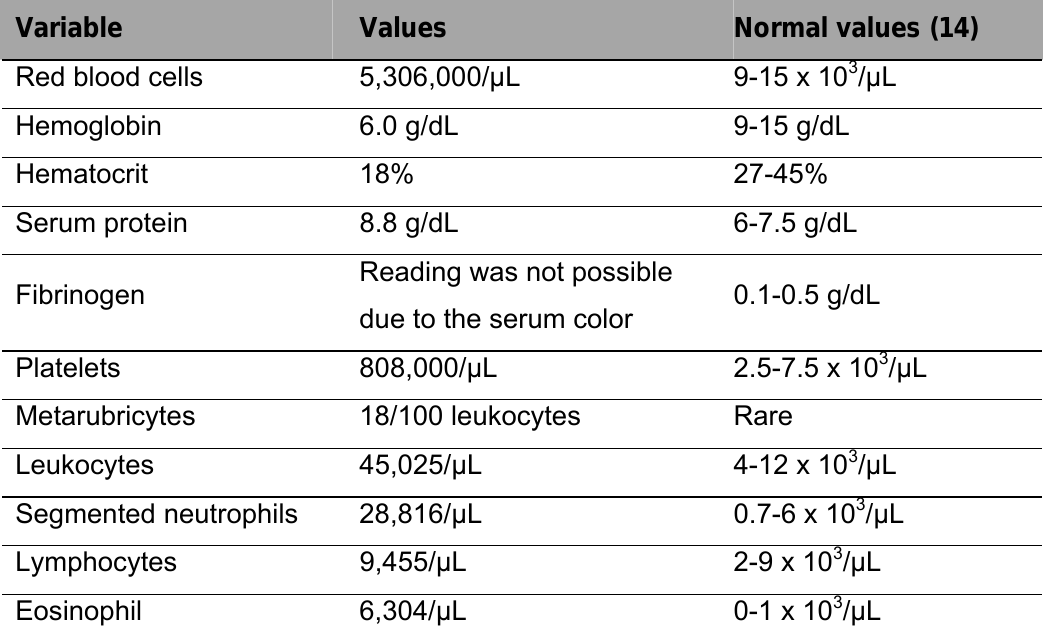
Table 1. Hemogram of a young ovine previously hyperimmunized with Crotalus durissus terrificus venom, 12 hours after hospitalization